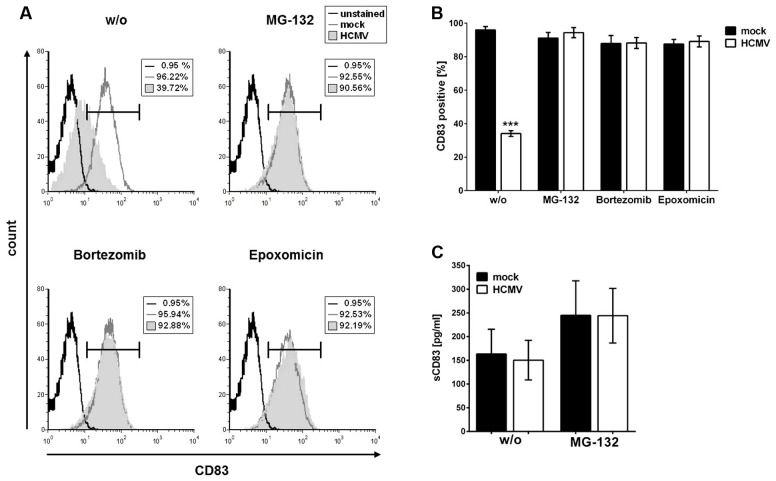
CD83 down-modulation can be prevented by inhibition of the proteasome. mDCs were mock- or HCMV-infected. One hour post-infection (hpi) cells were treated either with DMSO or with 10 μM MG-132, 2 μM Bortezomib, or 5 μM Epoxomicin. After additional 16 h of incubation cells were harvested and analyzed for their CD83 surface expression using flow cytometry. (A) Results of flow cytometric analyses. Overlays of mock sample (dark gray histogram), HCMV-infected sample (filled gray histogram) and unstained condition (black histogram), as negative control, are shown. The experiment was performed three times and representative data are shown. (B) Summary of three independent experiments performed as described above. Mock-infected cells (black bars) were used as controls and treated in the same way as HCMV-infected samples (white bars). Significant changes (∗∗∗p < 0.001) are indicated by asterisks. (C) Detection of soluble CD83 by ELISA in the supernatant of mock- or HCMV-infected mDCs. mDCs were infected as described above and treated with or without 10 μM MG-132 1 hpi. After additional 16 h the supernatant was harvested and analyzed for their soluble CD83 content using ELISA. Mock- and HCMV-infected samples are depicted as black and white bars, respectively.